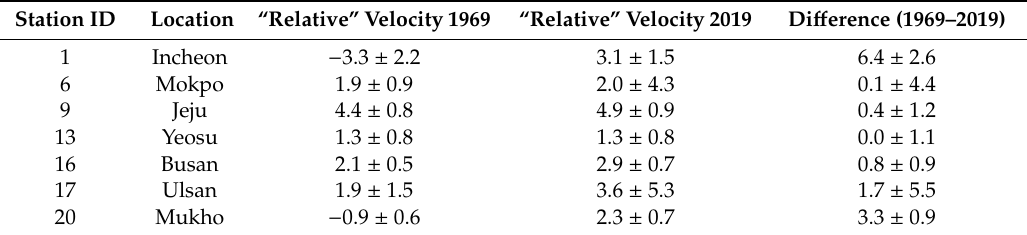
Table 3. Di ff erence in “relative” velocity over last 50 years (mm /